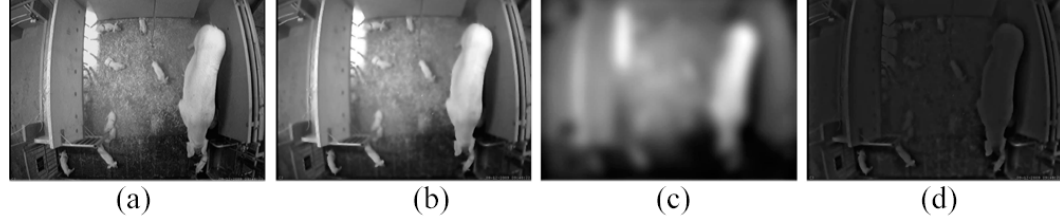
Figure 5. The wavelet quotient image (WQI) model evaluation: ( a ) the original image; ( b ) the diffusion image; ( c ) the coarse image; ( d ) the wavelet-quotient image ( i.e ., the reflectance